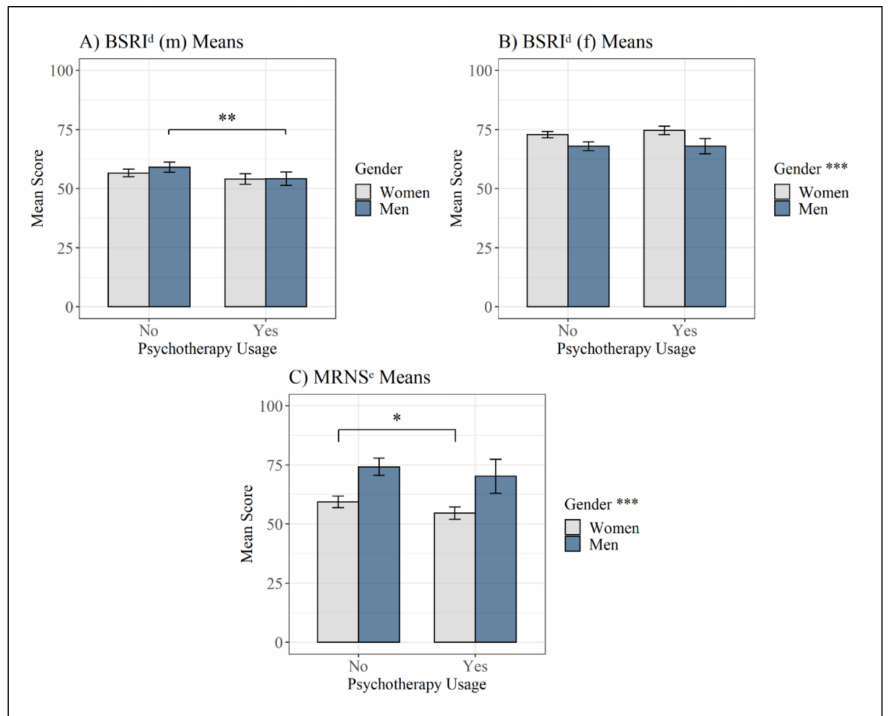
Figure 3. Mean scores on the gender role identity and role norm questionnaires in the different sub- groups with a 95% confidence interval. ( A ) BSRI d (m) Means; ( B ) BSRI d (f) Means; ( C ) MRNS e Means. Note: asterisks in the legend indicate a significant difference between the genders, regardless of psychotherapy use. d BSRI = Bem Sex-Role Inventory; e MRNS = Male Role Norm Scale; * = p < 0.05, ** = p < 0.01, *** = p <